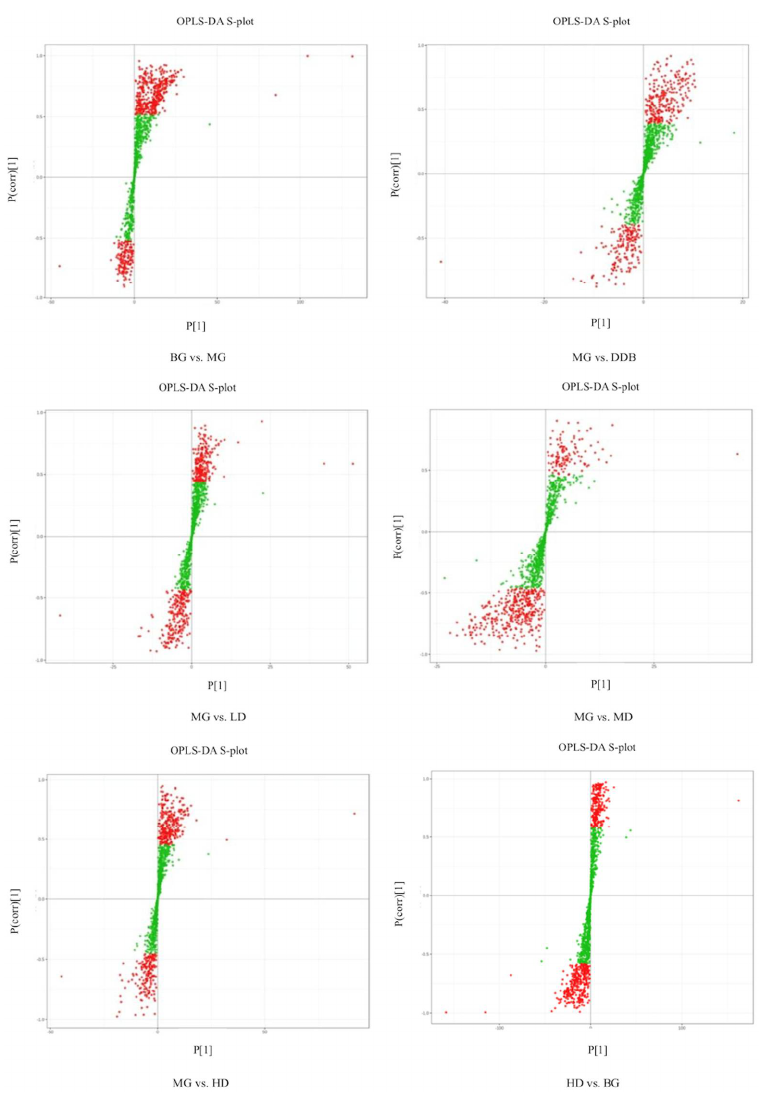
Figure 7. Heat map. The x-axis represents groups, and the y-axis represents differentially expressed genes. Data (peak areas) were normalized between −5 and 5 (green—the lowest level; red—the high- est level).